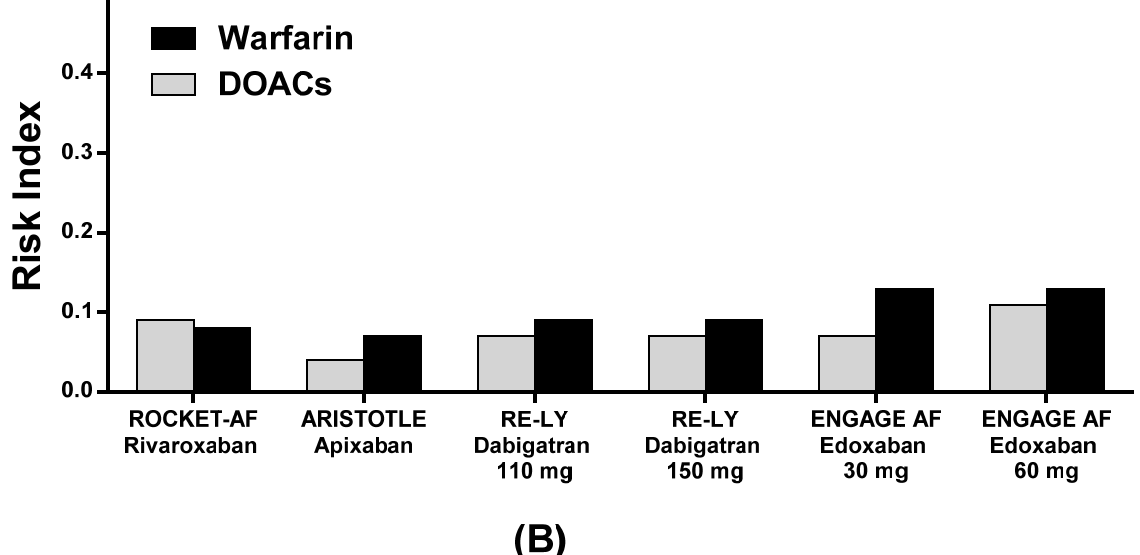
Figure 4. Risk index of Major Bleeding in patients with ( A ) and without ( B ) diabetes in the pivotal trials.